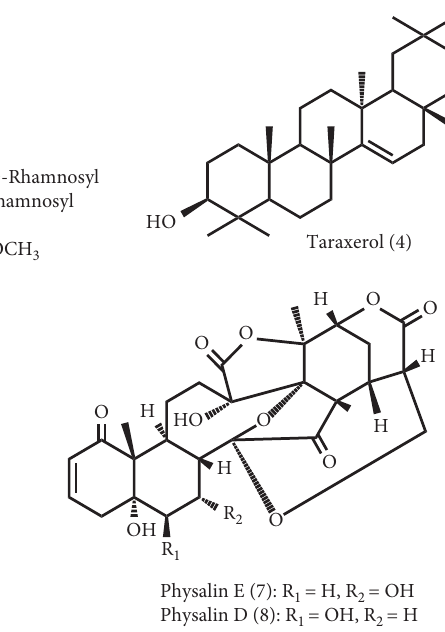
� R � H; R � O-Rhamnosyl. Afzelin ( 2 ): R 2 4 3